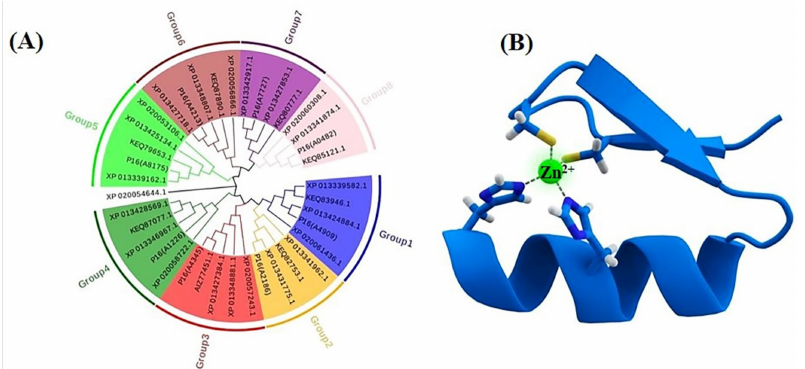
Figure 4. Phylogenetic tree of the C2H2 transcription factors ( A ) and the Cys2His2 zinc finger motif, consisting of α helix and an antiparallel β sheet ( B ). The zinc ion (green) is coordinated by two histidine residues and two cysteine